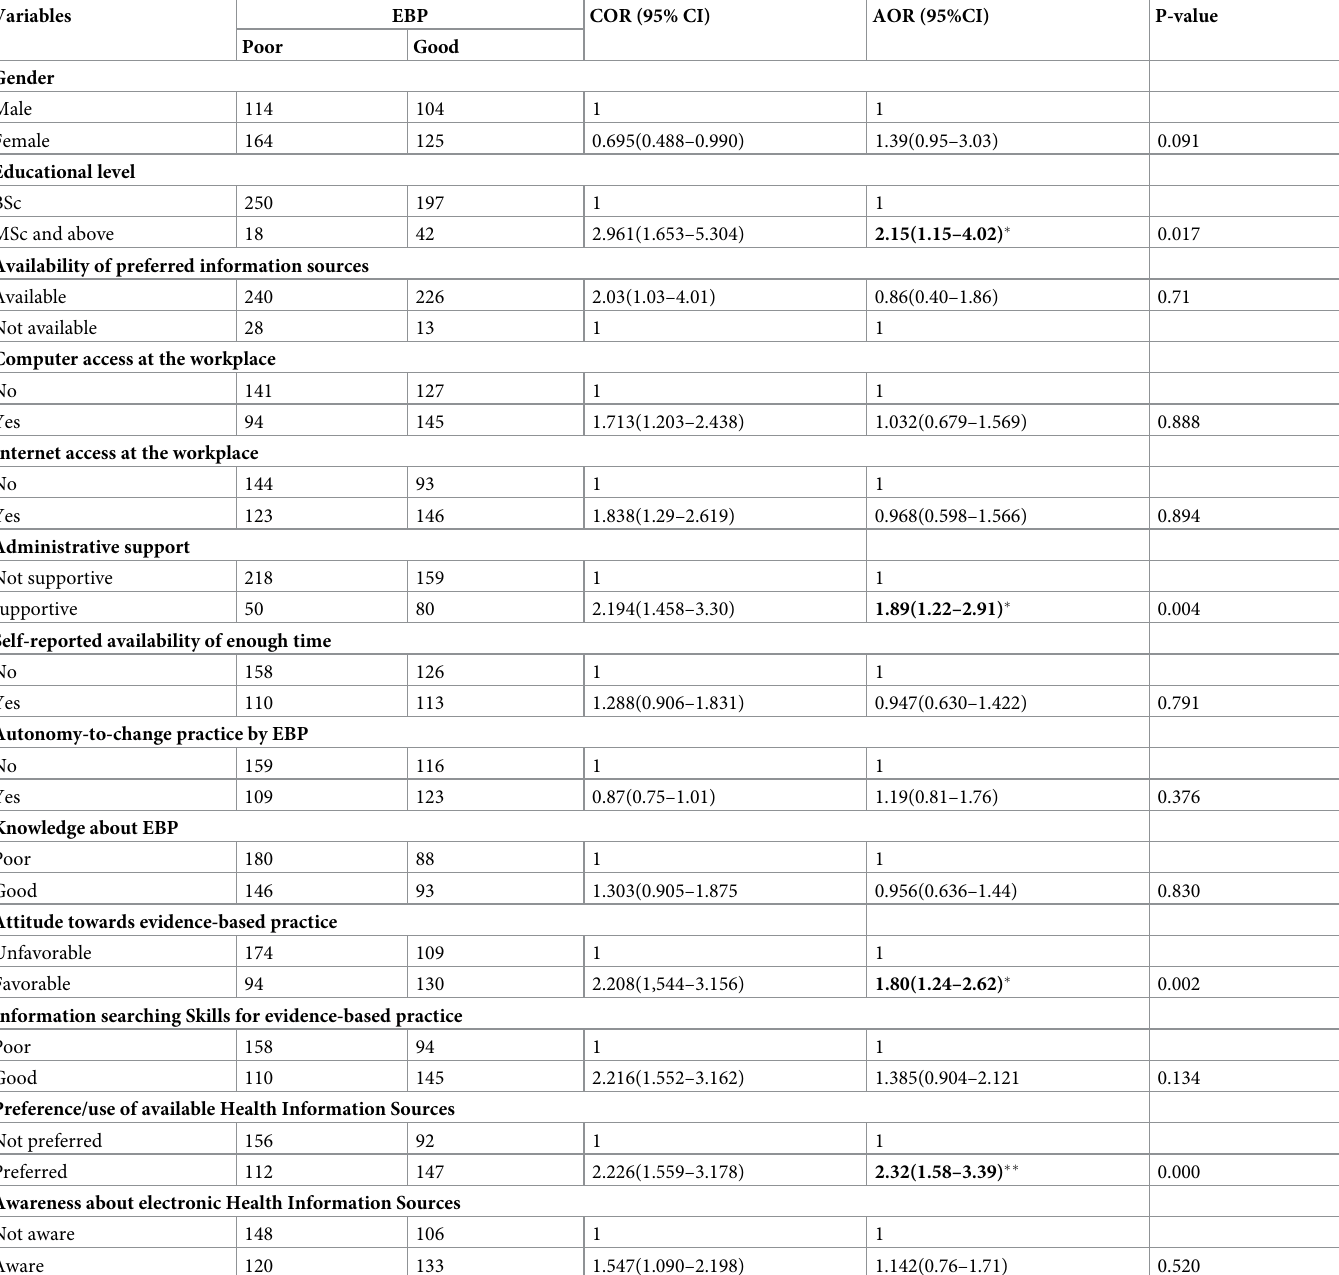
Table 3. Bi-variate and multivariable analysis of evidence-based practice among nurses of the University of Gondar and Tibebe Gion teaching specialized hospitals, Ethiopia 2020 (n =